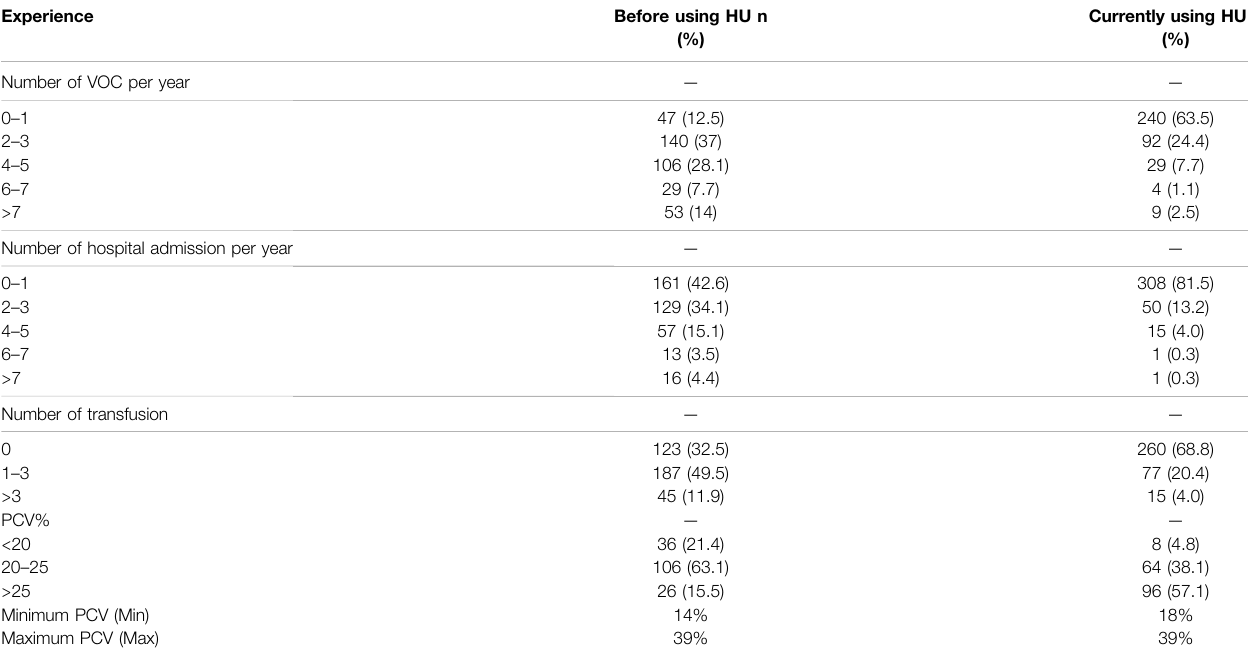
TABLE 4 | Experience with the use of hydroxyurea